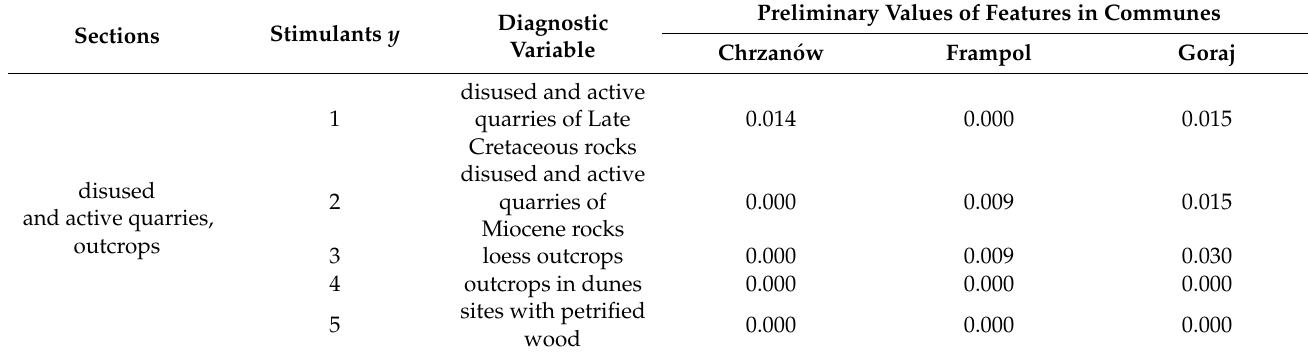
Table 2. Preliminary values of the geotourism potential in some communes.